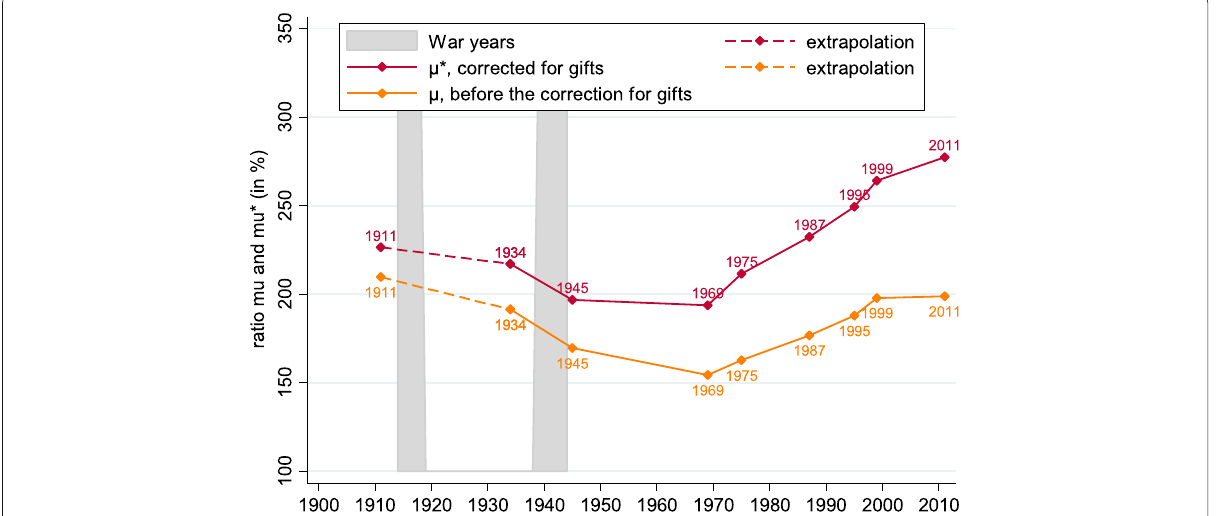
Fig. 1 Evolution of the ratio of wealth at death and wealth while alive (uncorrected for gifts, μ t and corrected for gifts, μ ∗ t ). Notes: see text for data sources, and Table 1 for data